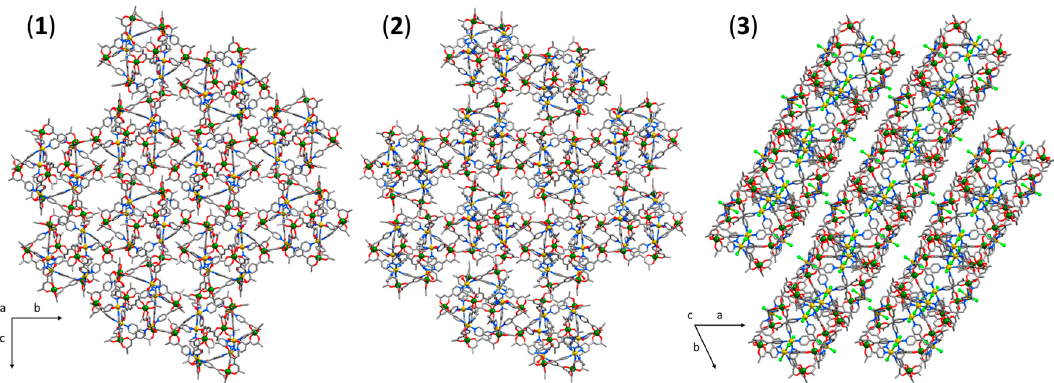
Figure 3. Packing diagrams of ( 1 )–( 3 ) viewed down the a -, a -, and c -axis, respectively. Colour code as in Figure 1.